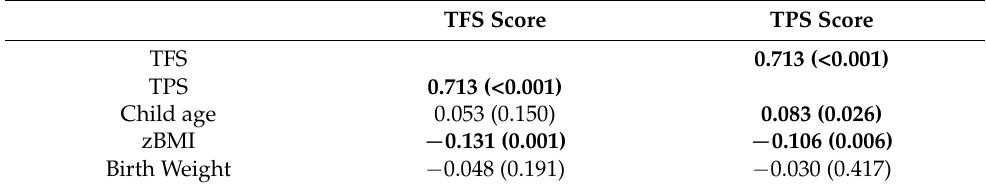
Table 3. Bivariate correlations between TFS and TPS score and age, zBMI, and